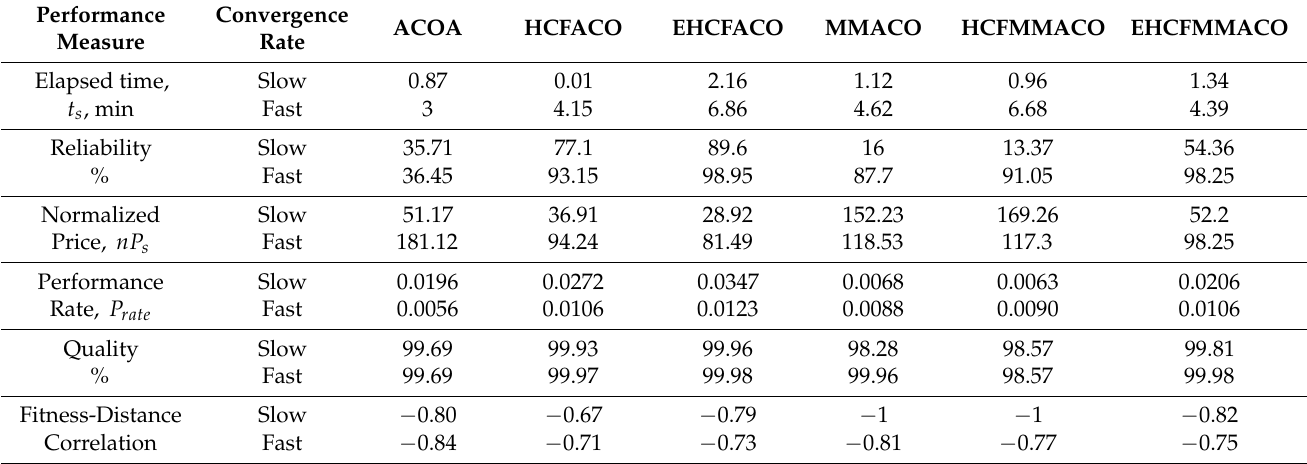
Table 3. The performance measures of Hyper-Cube Framework ACO